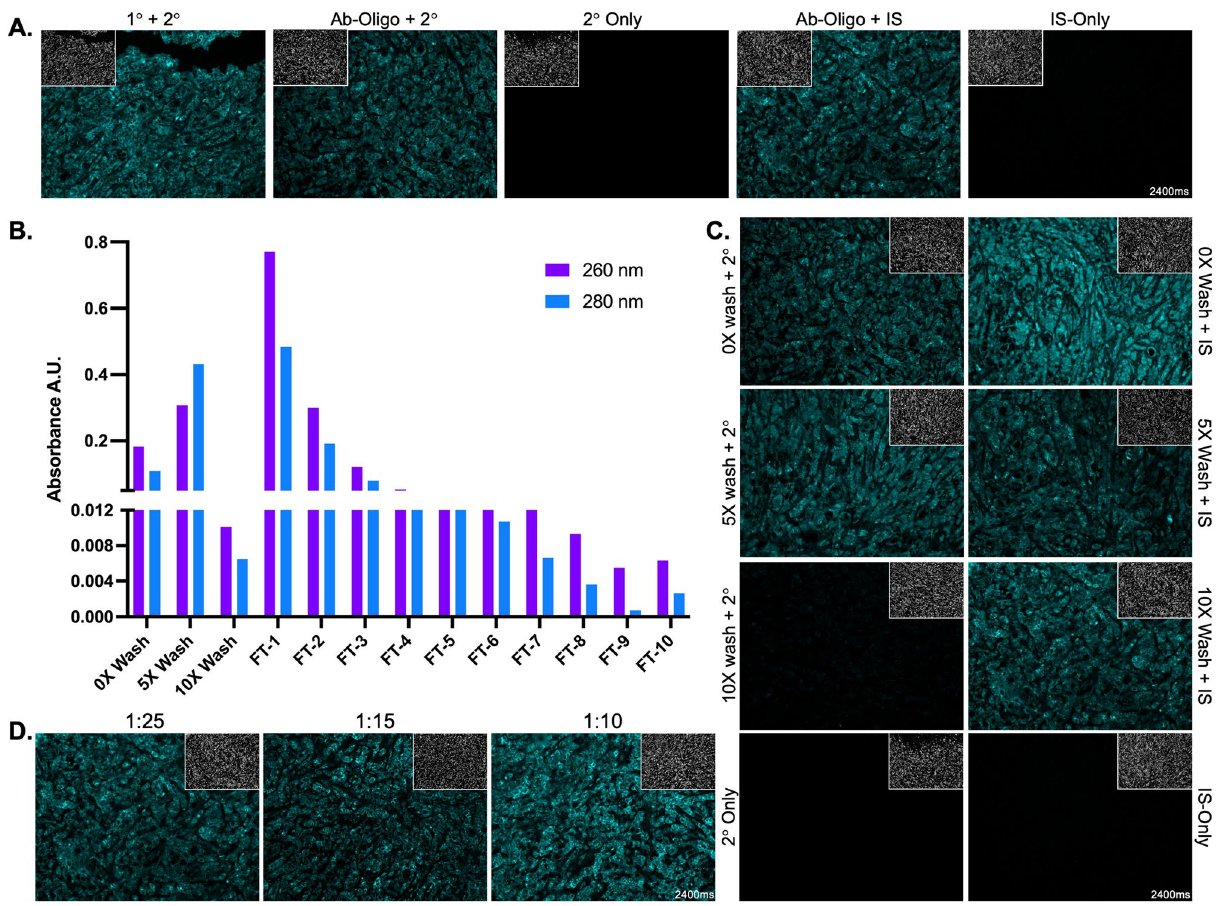
Figure 2. Ab-oligo conjugate validation and purification. ( A ) Representative Ab-oligo validation imaging panel demonstrated the maintained binding affinity and specificity of the Ab-oligo conjugate by comparing the staining patterns of unconjugated E-Cadherin (E-Cad) primary antibody (1°) + fluorophore-conjugated secondary antibody (2°), E-Cad Ab-oligo conjugate + 2°, 2°-Only control, E-Cad Ab-oligo conjugate + IS and IS-Only control. ( B ) After Ab-oligo conjugation, unbound DS was removed through a series of PBS washes (5–10 washes) where oligo and antibody loss were estimated through absorbance measurements at 260 and 280 nm, respectively. The flow-through (FT) fractions were also measured at 260 and 280 nm to monitor removal of any unbound DS from the conjugate as wash number increased. ( C ) Functionality of the E-Cad Ab-oligo conjugate after 0, 5× and 10× washes was compared to conventional indirect immunofluorescence staining to verify binding affinity and specificity of the Ab-oligo conjugate. ( D ) Ab-oligo conjugate concentration titration after purification restored marker specific